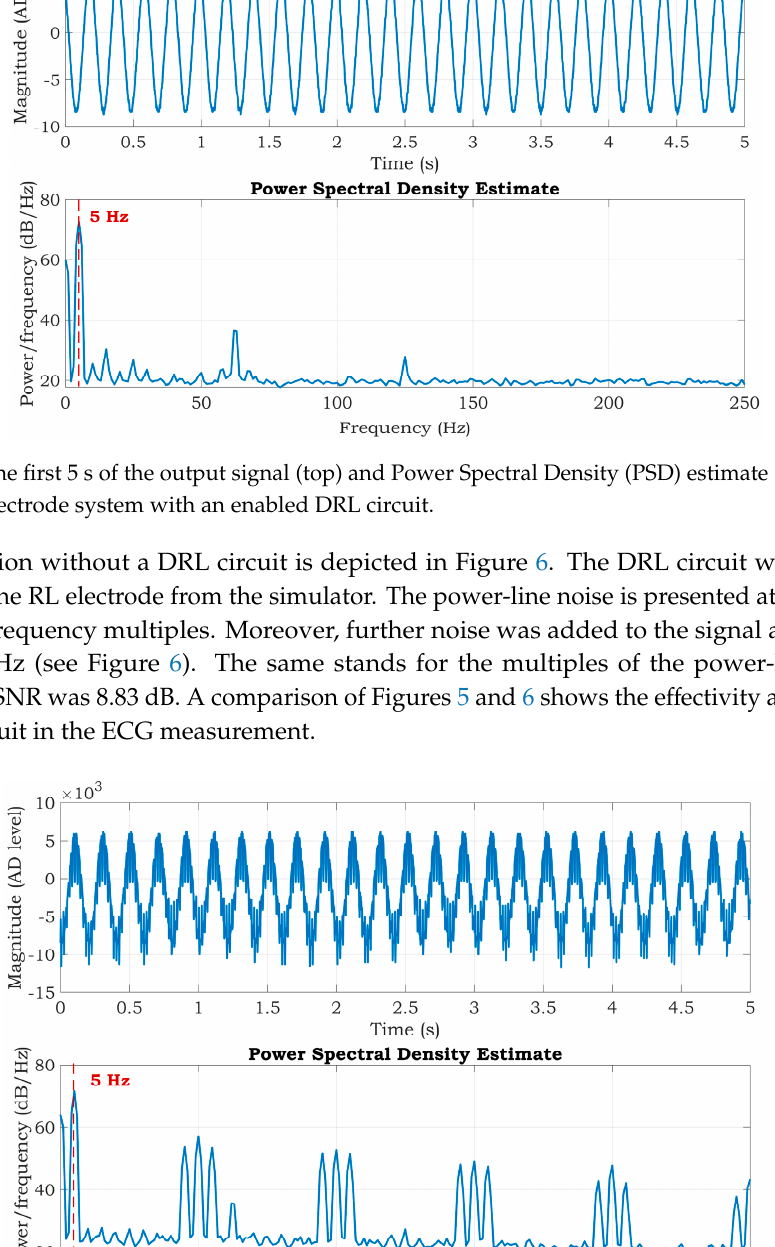
Figure 6. The first 5 s of the output signal (top) and PSD estimate (bottom) of the three-electrode system with a disabled DRL circuit.